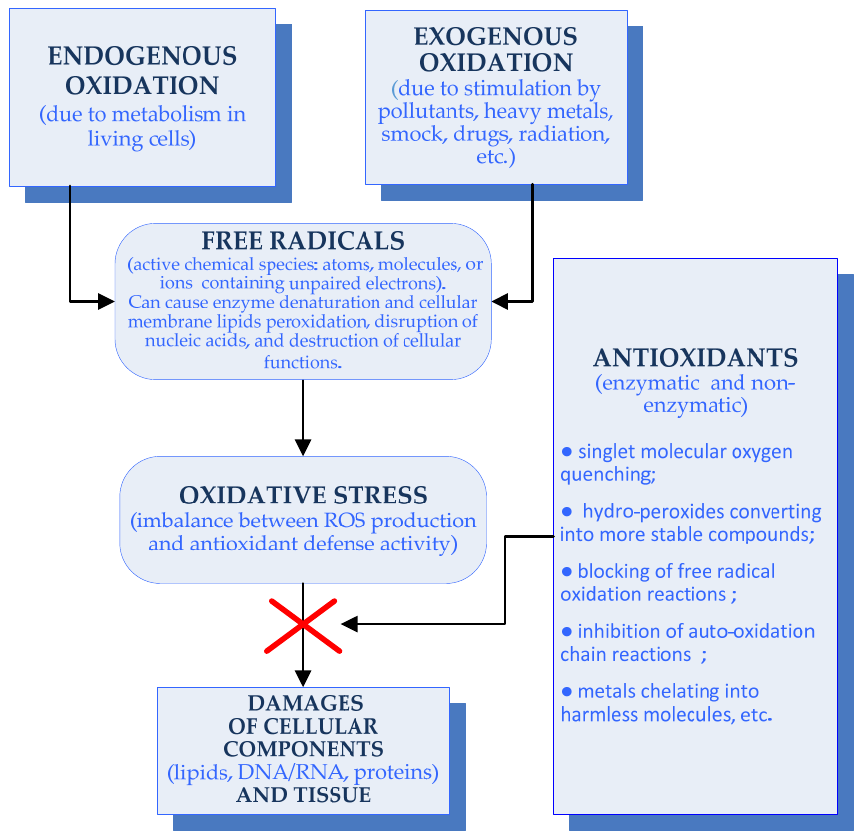
Figure 1. Simple sketch of oxidation process and effects of antioxidants.